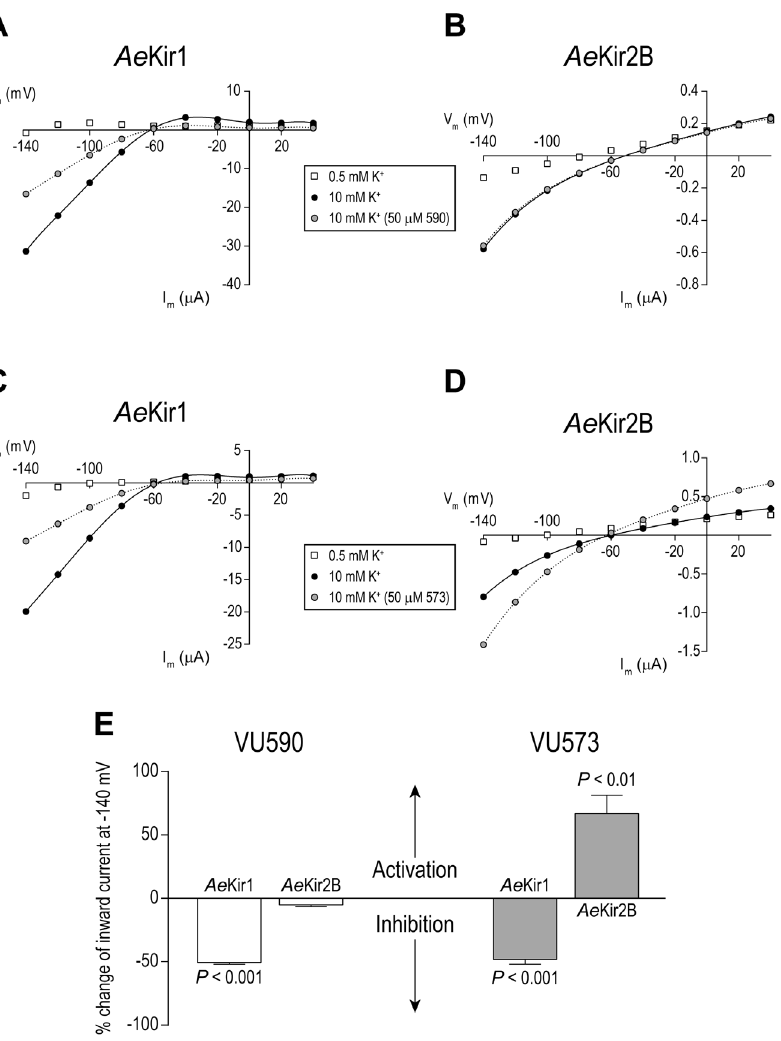
Figure 2. Effects of VU590 and VU573 on Ae Kir1 and Ae Kir2B channels expressed heterologously in Xenopus oocytes. Current-voltage (I–V) relationships of representative Ae Kir1 (A, C) and Ae Kir2B (B, D) oocytes bathed consecutively in solutions containing 0.5 mM K + (open boxes), 10 mM K + (filled circles), and 10 mM K + + 50 m M of a small molecule (gray circles). The small molecule is VU590 in panels ‘A’ and ‘B’, and VU573 in panels ‘C’ and ‘D’. (E) Summary of the percent changes of inward currents at 2 140 mV in Ae Kir1 and Ae Kir2B oocytes elicited by VU590 and VU573. Positive and negative percent changes indicate activation and inhibition, respectively. P values indicate significant activation or inhibition as determined by a one sample t test (on arcsine transformed values). Values are non-transformed means 6 SEM. For VU590 experiments, n =3 oocytes each for Ae Kir1 and Ae Kir2B. For VU573 experiments, n =5 and 8 oocytes each for Ae Kir1 and Ae Kir2B, respectively.